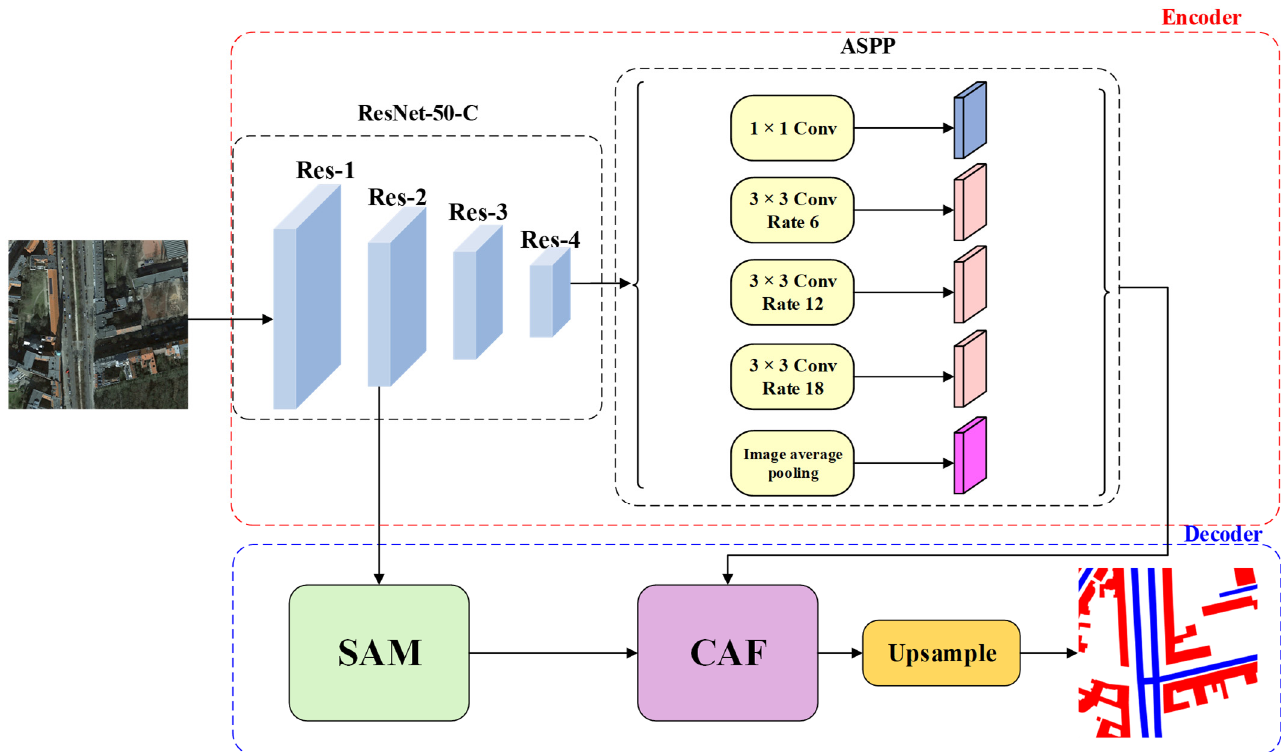
Figure 4. Structure of our proposed SANet.